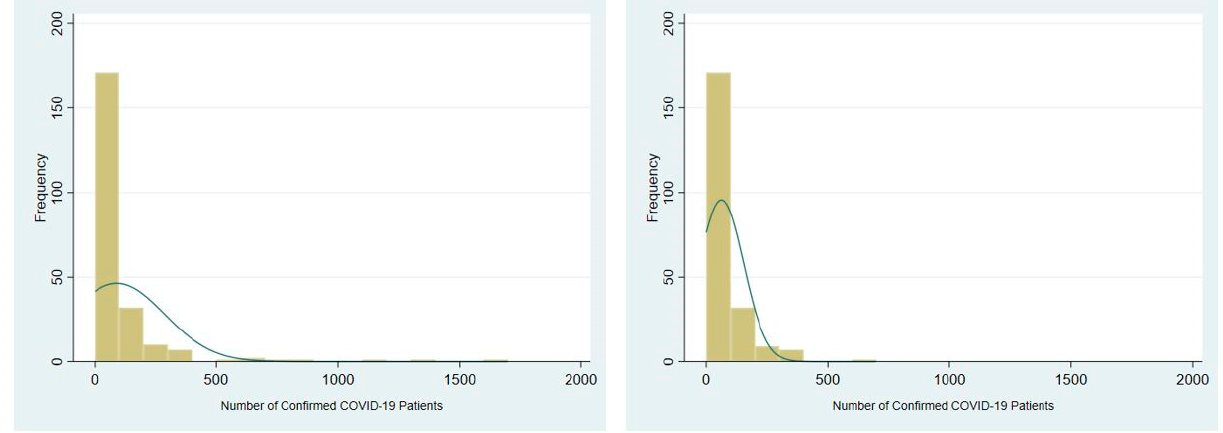
Figure 2. Frequency of COVID-19 cases with Daegu ( left ) and without Daegu ( right ).